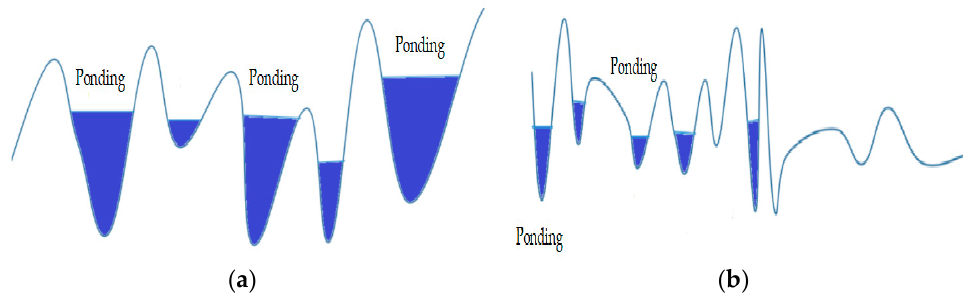
Figure 17. Two types of mixes with water logging methods. ( a ) Basalt–asphalt mixes textured with ponding water; ( b ) steel slag–asphalt mixes textured with ponding water. ponding water; ( b ) steel slag–asphalt mixes textured with ponding